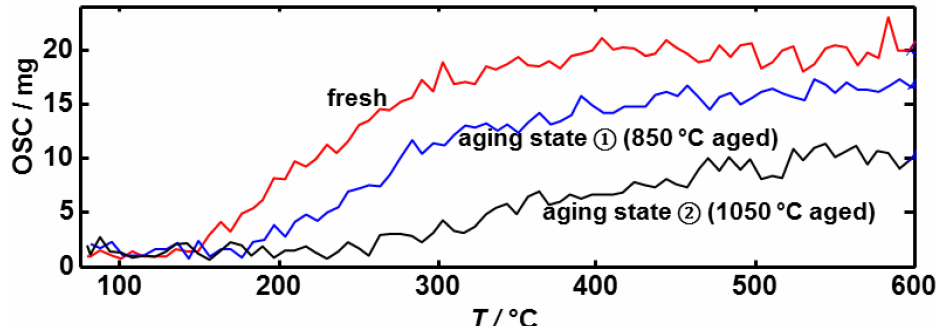
Figure 3. Oxygen storage capacity (OSC) during light-off tests with alternating rich-lean feed gases for samples with three different aging